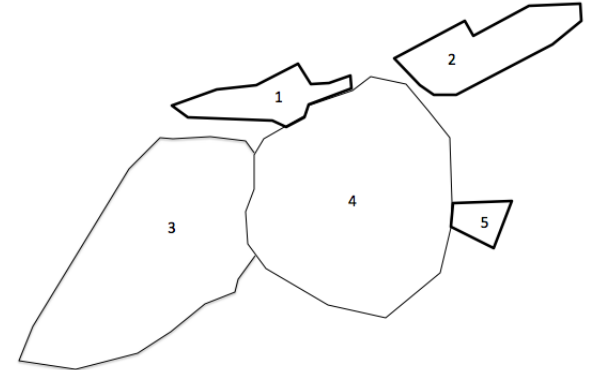
Figure 7. Spatial locations of RAL, old city, and industrial districts (1) Hui-gong Industrial District; (2) Shen-hai Industrial District; (3) RAL; (4) Old city; (5) Da-dong Industrial